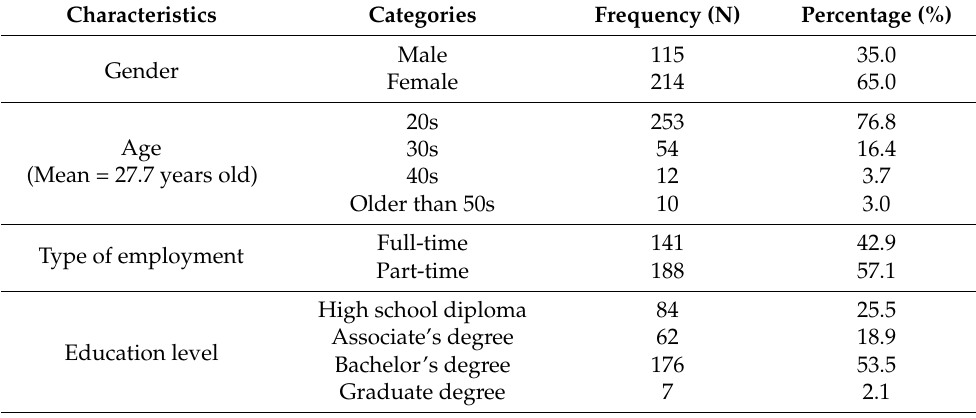
Table 1. Profile of respondents.